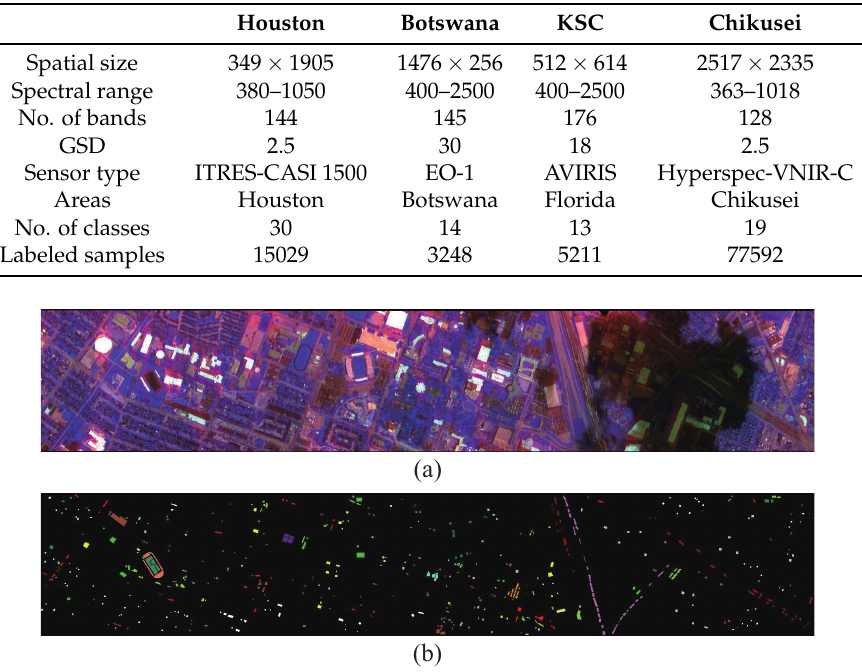
Table 1. Detailsof the source data sets. Kennedy Space Center (KSC), ground sample distance (GSD)(m),